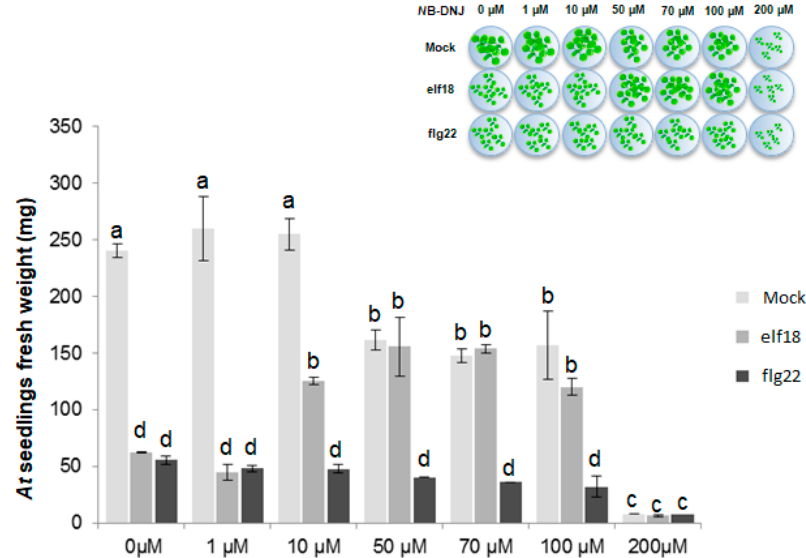
Figure 1. N B-DNJ toxicity assay. Arabidopsis thaliana ( At ) seedlings, Col-0 ecotype, were grown in Murashige and Skoog (MS) half-strength liquid medium containing different concentrations of N B-DNJ in combination with 100 nM of elf18 or flg22 (inset). After 15 days of treatment, the fresh weight of seedlings was measured. Increasing concentrations of N B-DNJ resulted in increasing reduction in plant growth, with severe weight loss at 200 µM of N B-DNJ. Values represent the mean of at least five independent experiment (± s.e.; n = 5) with similar results in each experiment. Each letter (a, b, c and d) indicates a group of samples whose values are statistically equivalent to the ones in the same group, at the ( p < 0.01) level determined by ANOVA with Scheffè’s post hoc test.